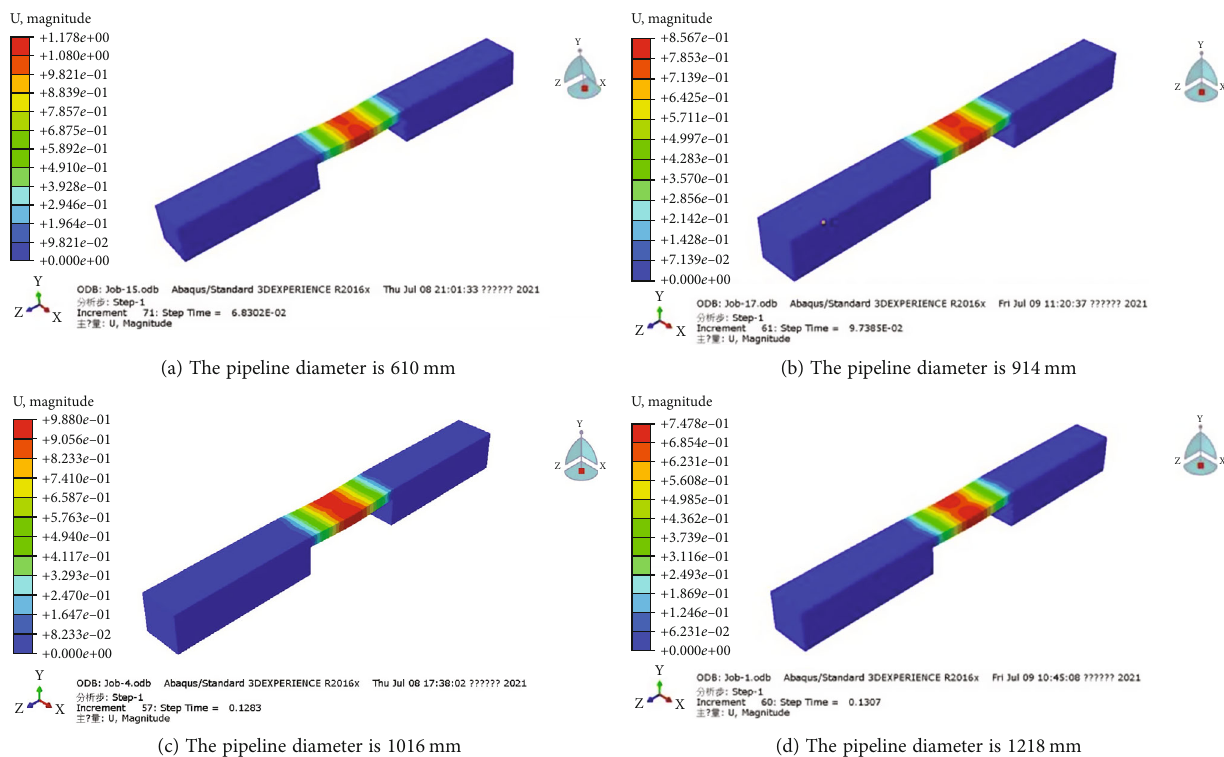
Figure 19: The soil displacement under di ff erent pipeline